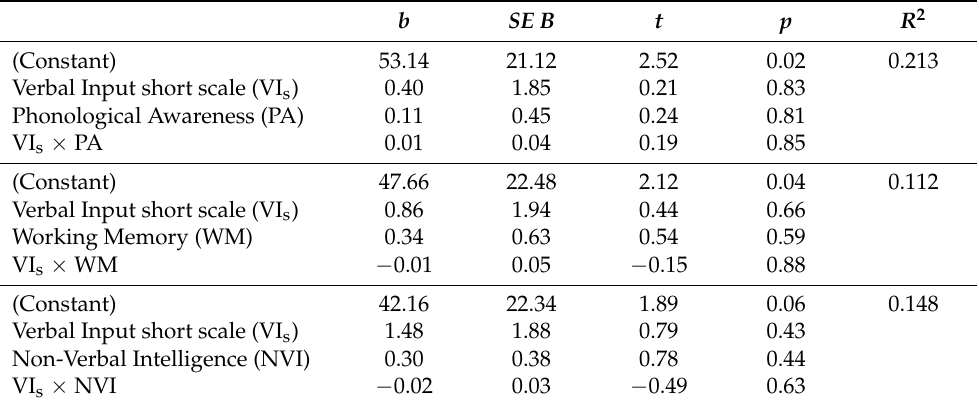
Table 6. Linear models of predictors of ELIAS Grammar Test 2 (EGT 2) with cognitive skills as moderating